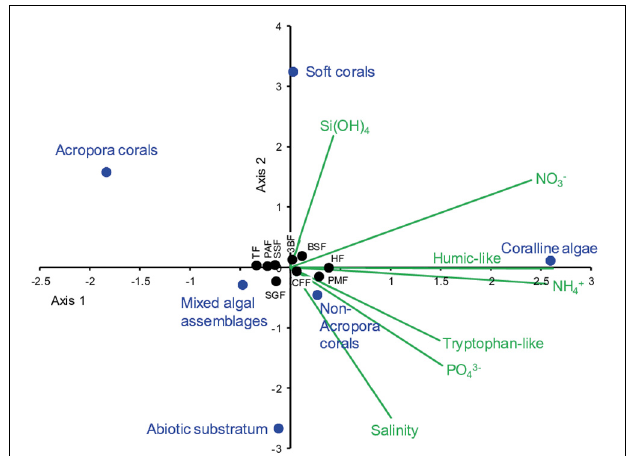
FIGURE 7 | Canonical correspondence analysis applied on some selected environmental variables (salinity, Si(OH) 4 , NO 3 - , NH 4 + , PO 43 - , humic-like, tryptophan-like fluorophores) and benthic communities (mixed algal assemblages, coralline algae, Acropora corals, non- Acropora corals, soft corals, abiotic substratum) recorded in fore reef waters/reef slope. For salinity and biogeochemical parameters, the mean values of samples n ◦ 1–6 were